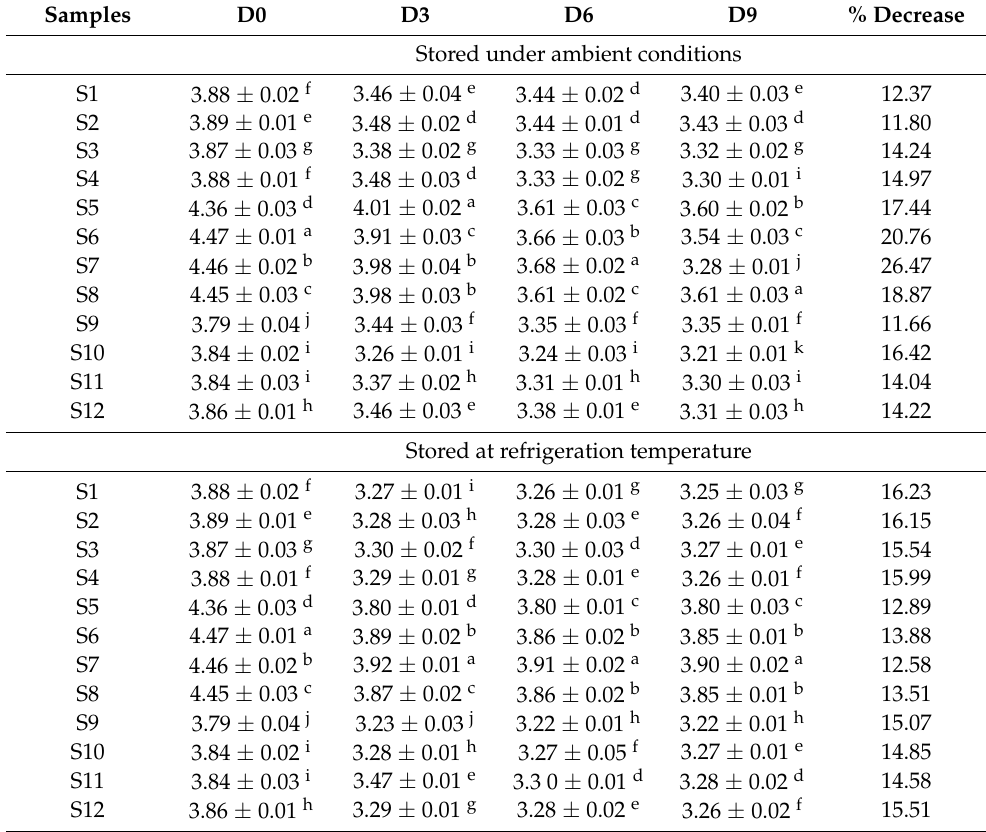
Table 2. Variation in pH of juice samples during the storage period under ambient conditions and refrigeration